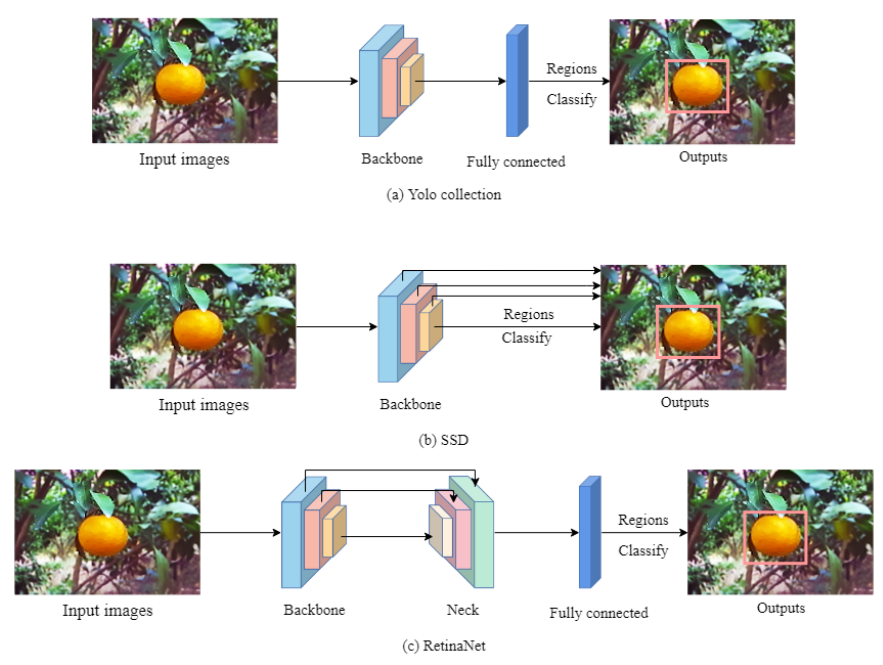
Figure 6. Regression-based one-stage target detection